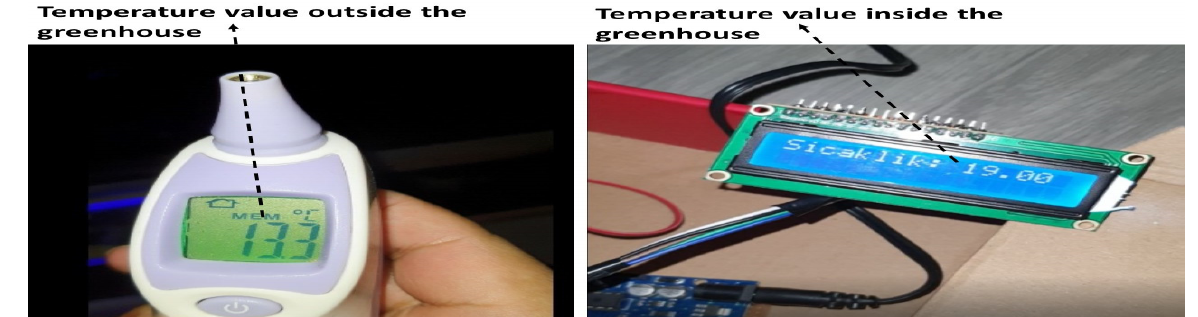
Figure 7. Temperature measurements at outdoor and in greenhouse.